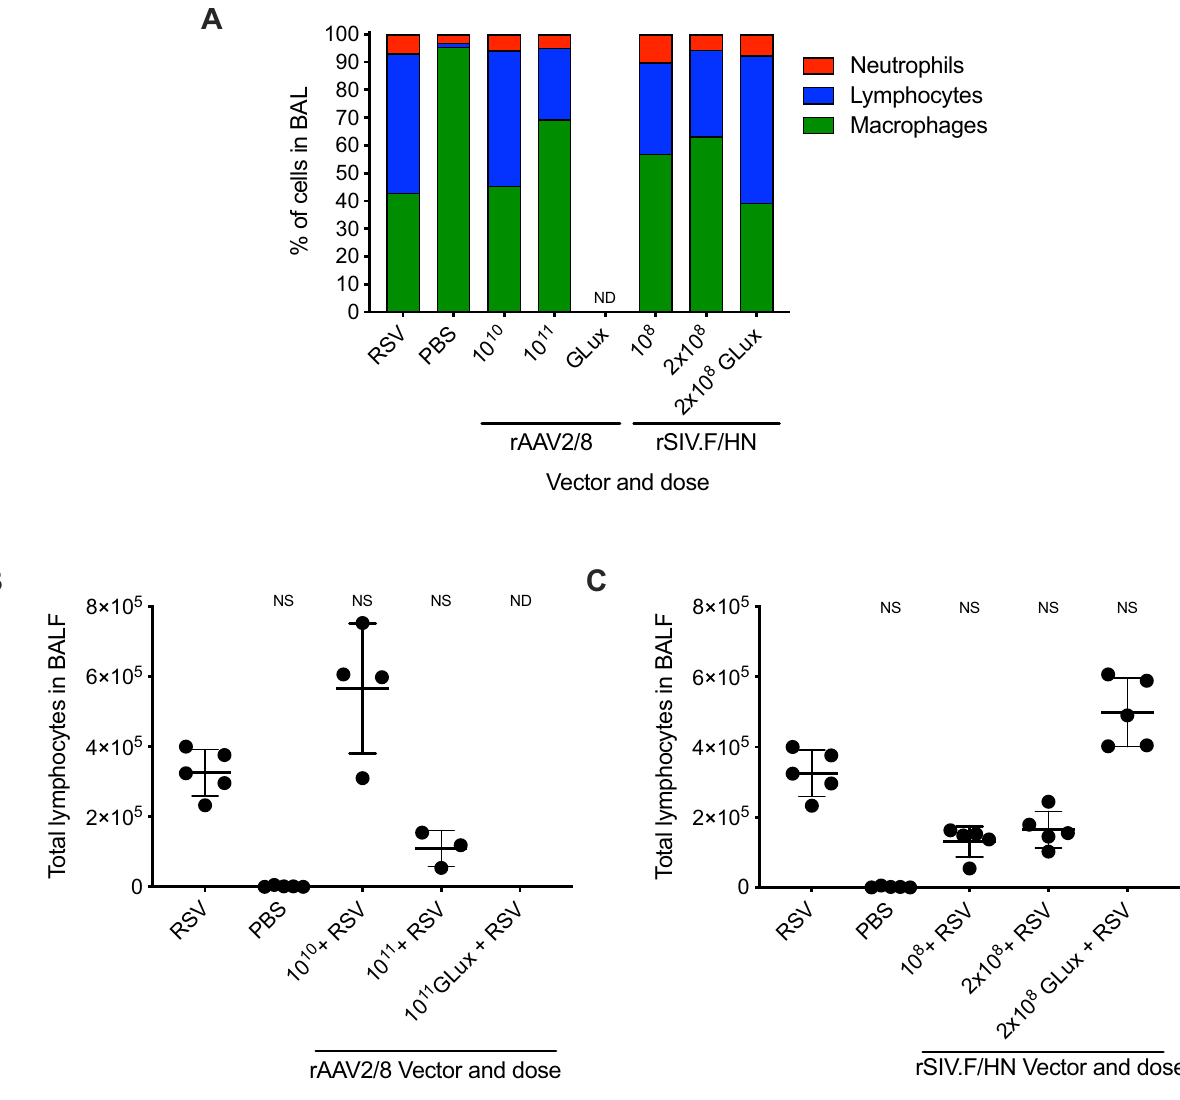
Figure 6. Changes in lung leukocyte cell populations following vector-mediated palivizumab gene transfer and subsequent RSV infection. Female BALB/c mice (n = 5/group) were administered rAAV2/8 vector expressing palivizumab (10 10 or 10 11 GC), or GLux (10 11 GC) via IM injection, or rSIV.F/HN vector expressing palivizumab (10 8 or 2 × 10 8 TTU) or GLux (2 × 10 8 TTU) via IN instillation. Twenty-eight days later, mice were infected with 7 × 10 5 FFU of RSV via IN instillation. Differential leukocyte quantification was carried out on